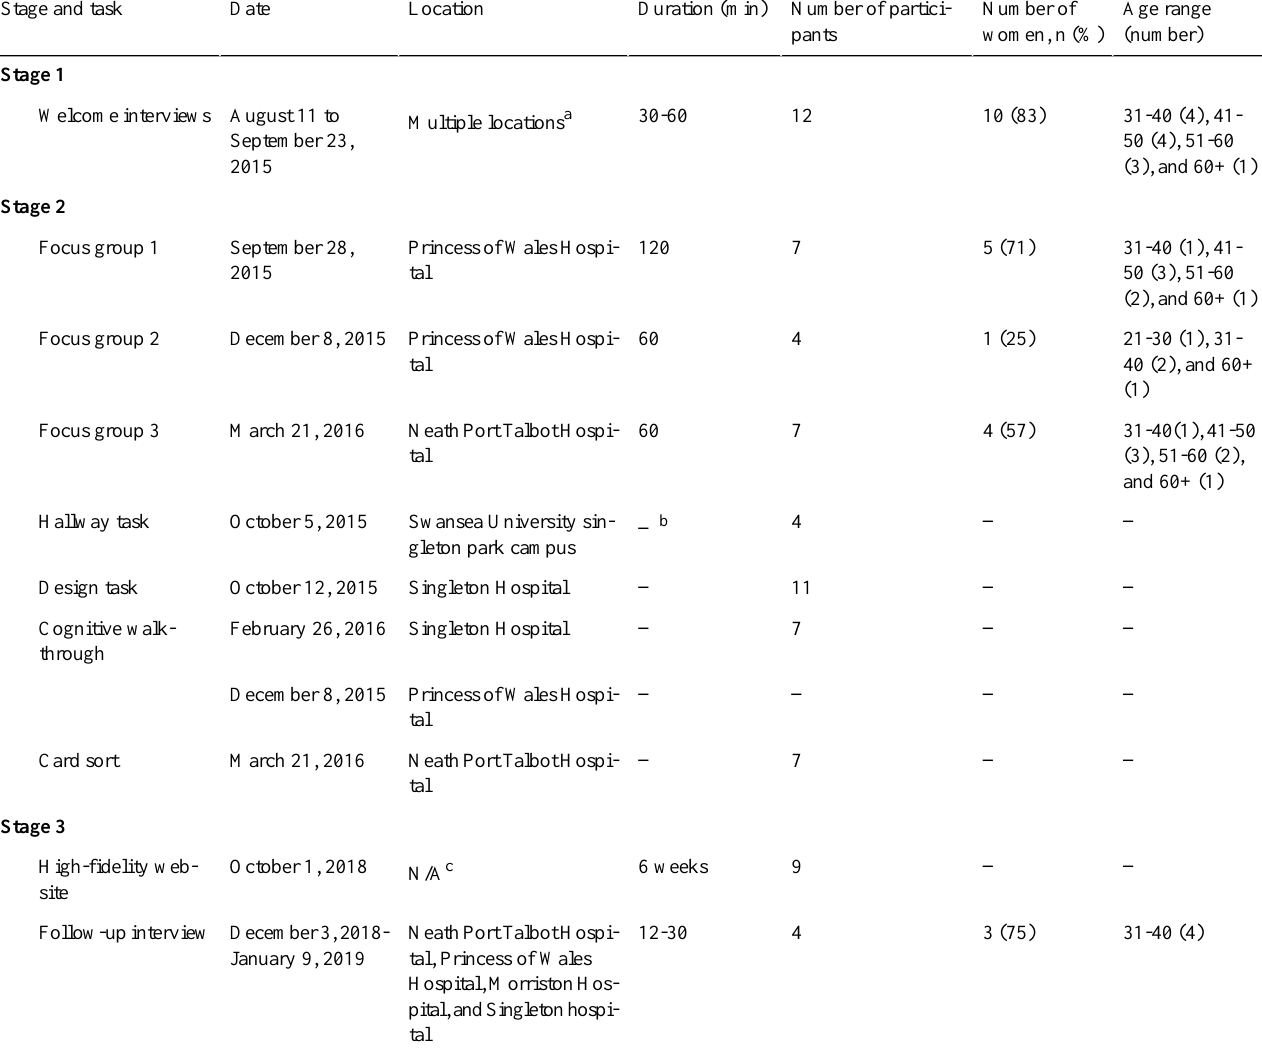
Table 2. Participant